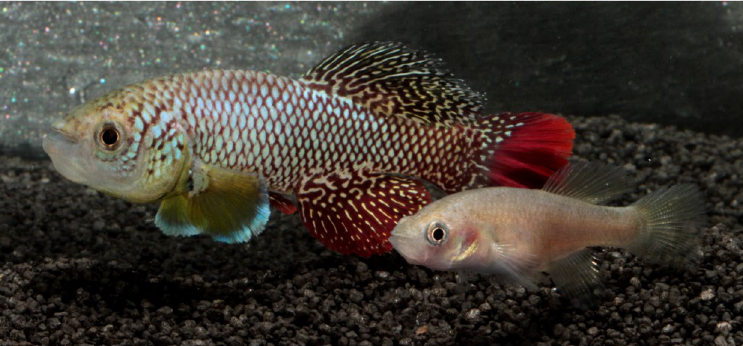
Figure 1. Male and female of turquoise killifish, Nothobranchius furzeri